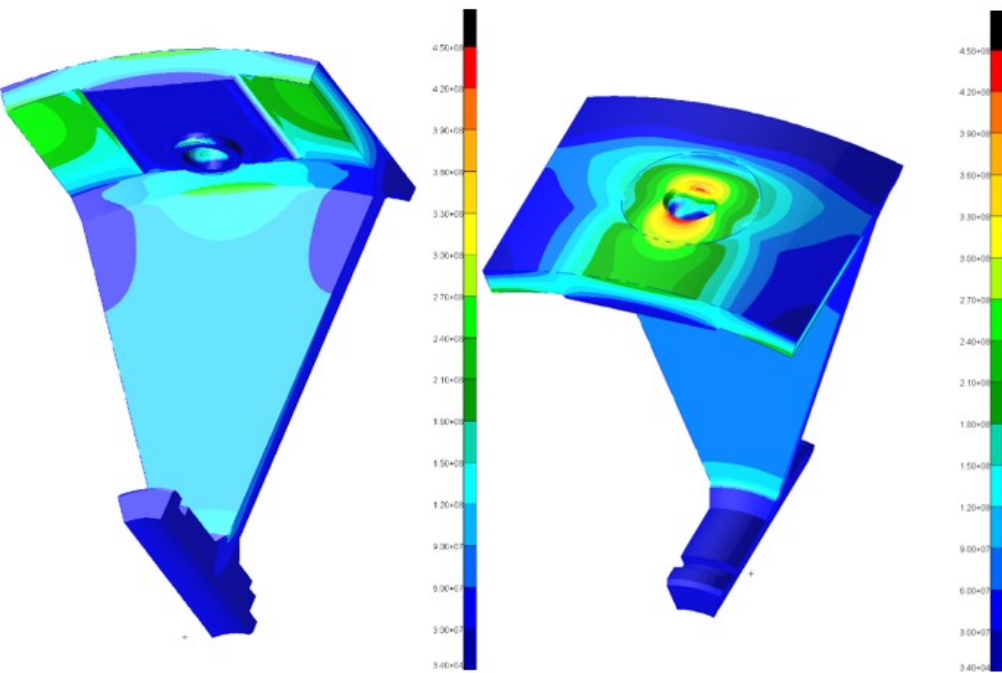
Figure 12. Rotor’s reduced stress map. The maximum values reach 235 MPa.